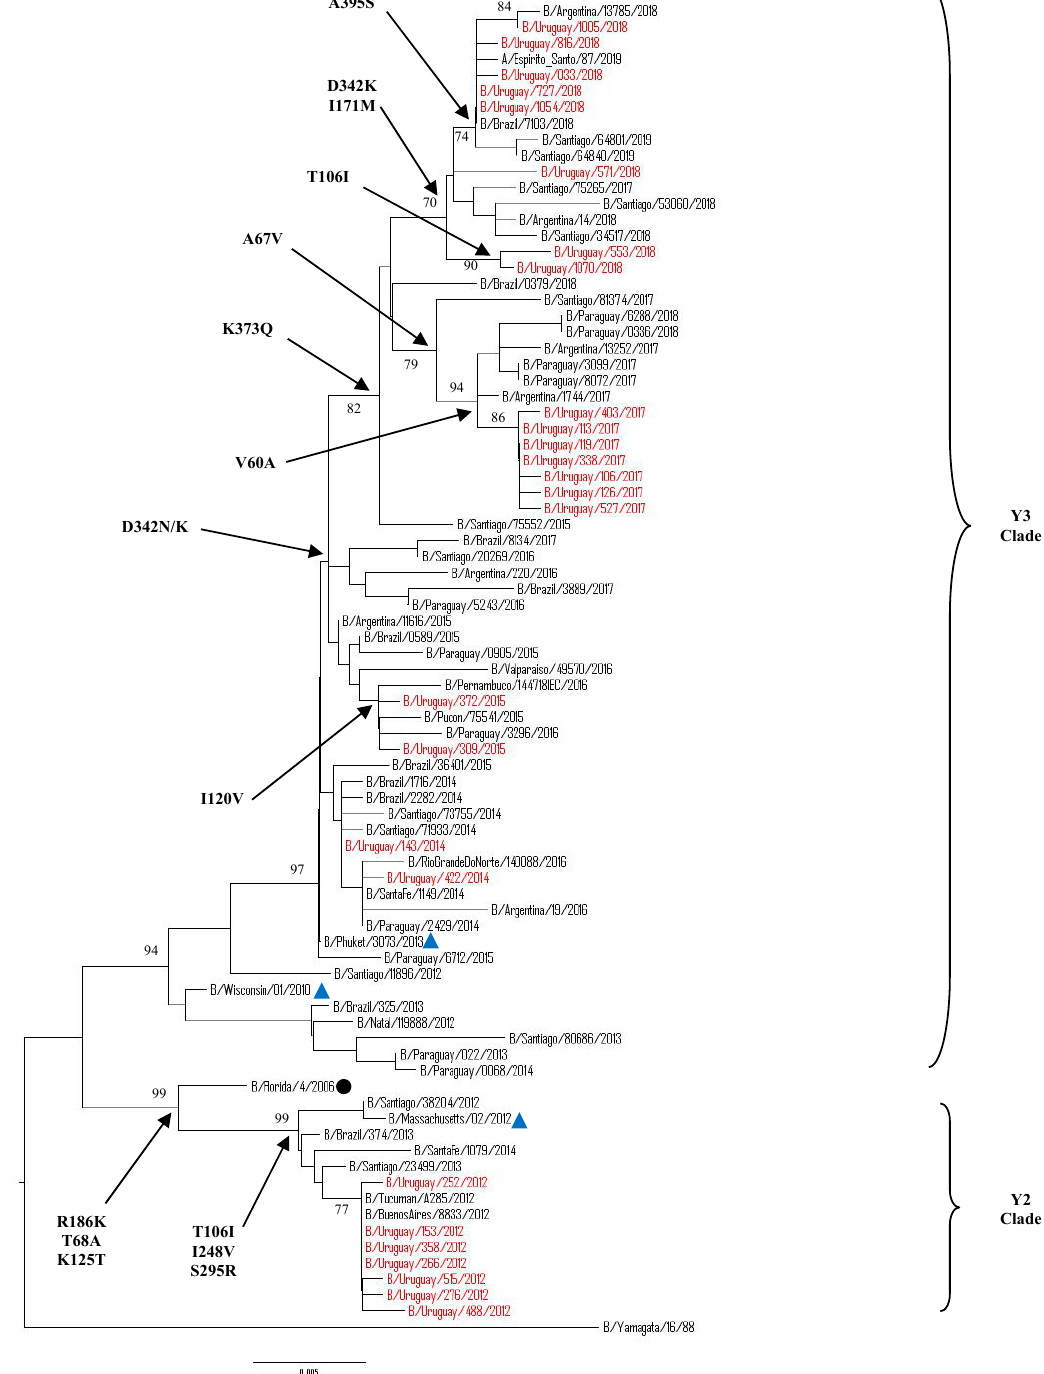
Figure 7. Phylogenetic analysis of the partial neuraminidase nucleotide sequences from influenza B Yamagata-lineage viruses circulating in Uruguay from 2012 to 2019. The phylogeny tree was generated by the neighbor-joining method with 1000 bootstrap replicates. Bootstrap values > 70 are shown in the nodes. Vaccine strains are shown with a blue triangle. Uruguayan strains are shown in red while representative clade strains are indicated with a black circle as a symbol. The scale bar indicates substitutions per site. The most relevant amino acid substitutions found are indicated with arrows.